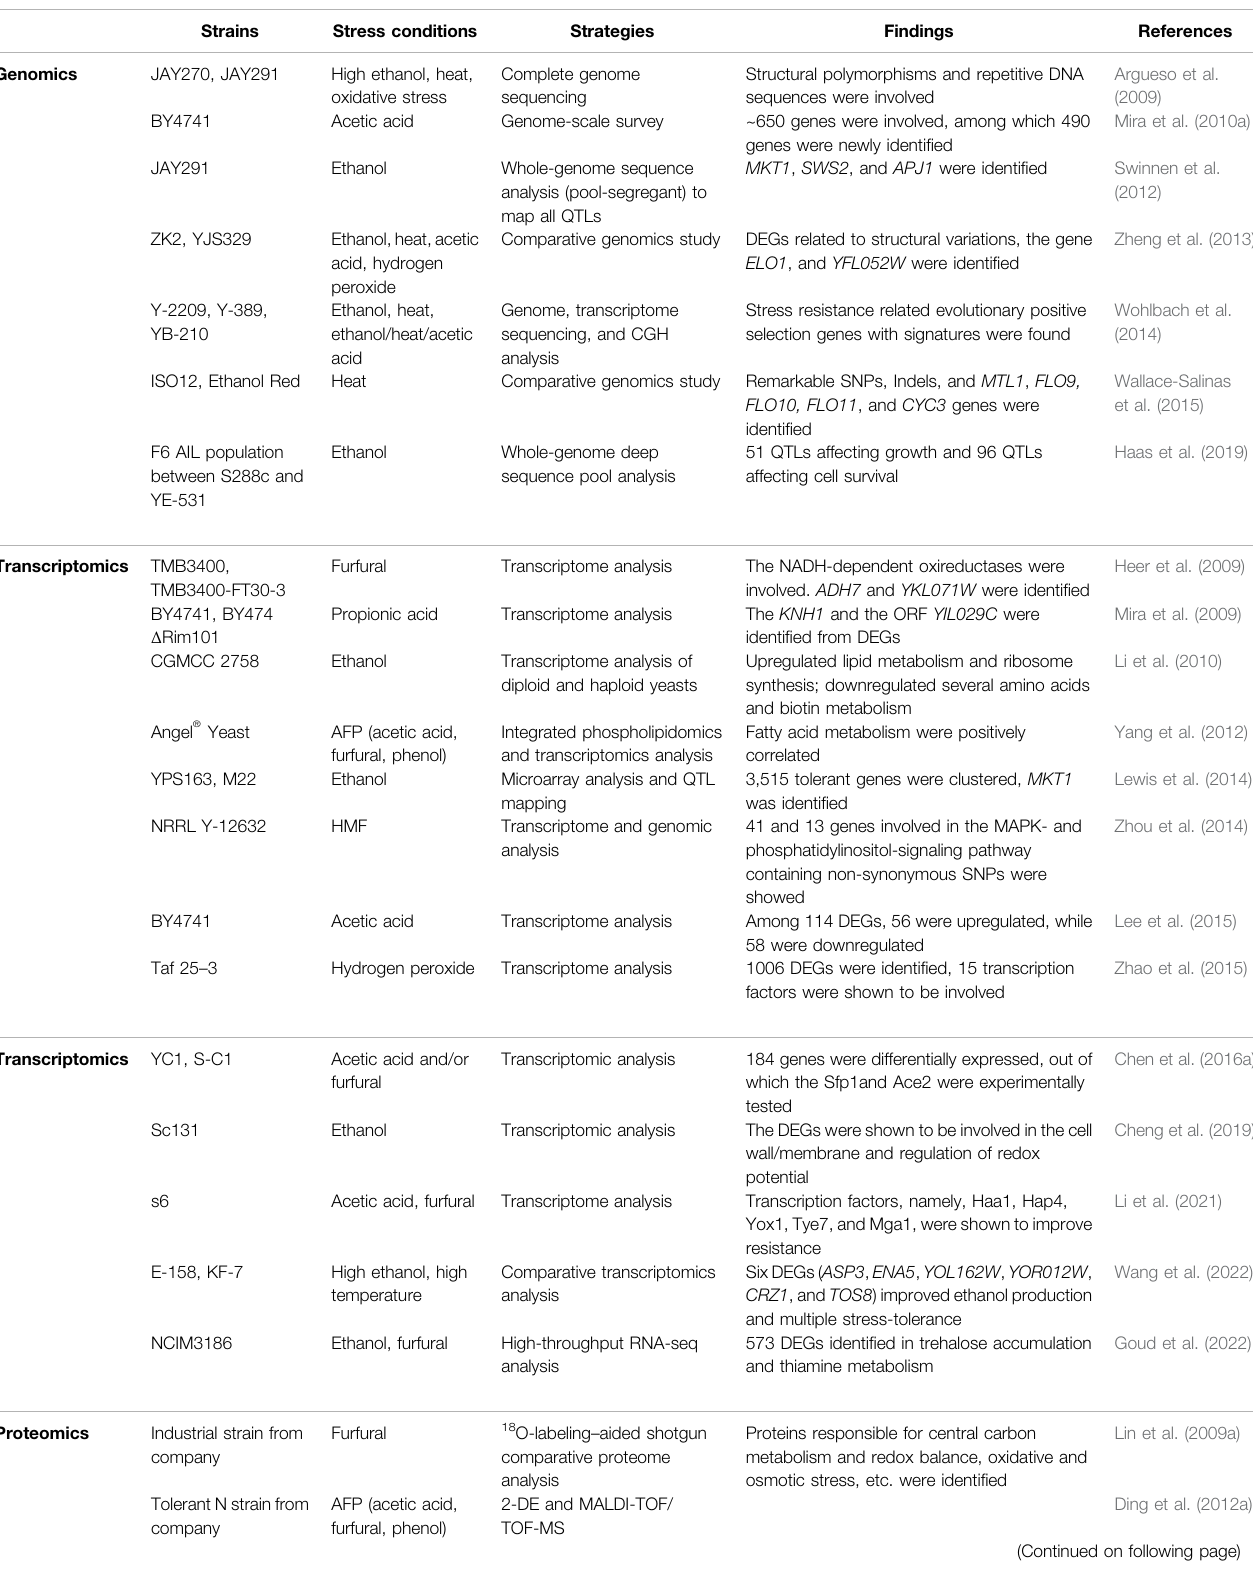
TABLE 1 | Representative examples of “ OMICs ” study of S. cerevisiae stress tolerance for fuel